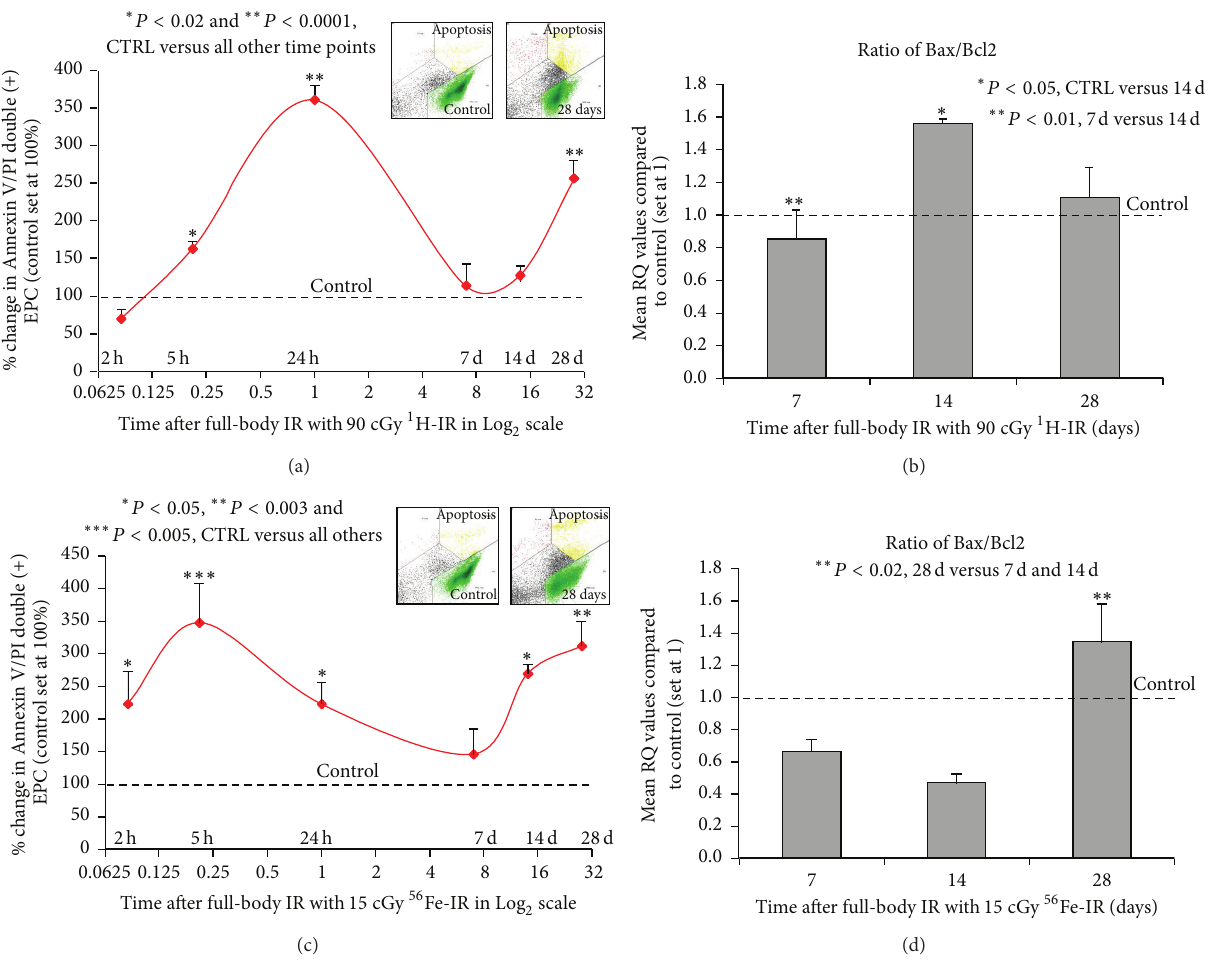
Figure6:Full-body 1 H-IRand 56 Fe-IRinducesearly(2–24h)anddelayed(14–28days)apoptosisinBM-EPCs exvivo .Graphicrepresentation of mean % change in Annexin V and propidium iodide (P.I) double positive (+) BM-EPCs cultured ex vivo for 72 h (solid red line) after full- bodysingle-doseIRof(a)90 cGy 1 H-IRmiceand(c)15 cGy 56 Fe-IRmiceat2,5,and24hoursand7,14,and28daysafterIR.Thecorresponding control for each time point was set at 100%. Insets in (a) and (c) are representative flow cytometry analysis plots for corresponding control and 28-day time points. Graphic representation of qRT-PCR analysis, mean RQ values compared to control (which was set at 1) of BM-EPCs from full-body single-dose IR of (b) 90 cGy 1 H-IR mice and (d) 15cGy 56 Fe-IR mics at 7, 14, and 28 days after IR for ratio of Bax/Bcl2. The corresponding control for each time point was set at 1. Graphs represent mean ± SEM of the pooled data from 5-6 independent biological samples/experiments. Statistical significance was assigned when 𝑃 < 0.05